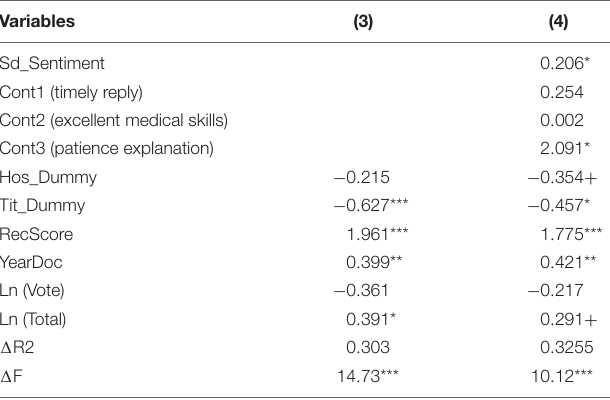
TABLE 8 | Content sentiment and content classification on the recent 2-week